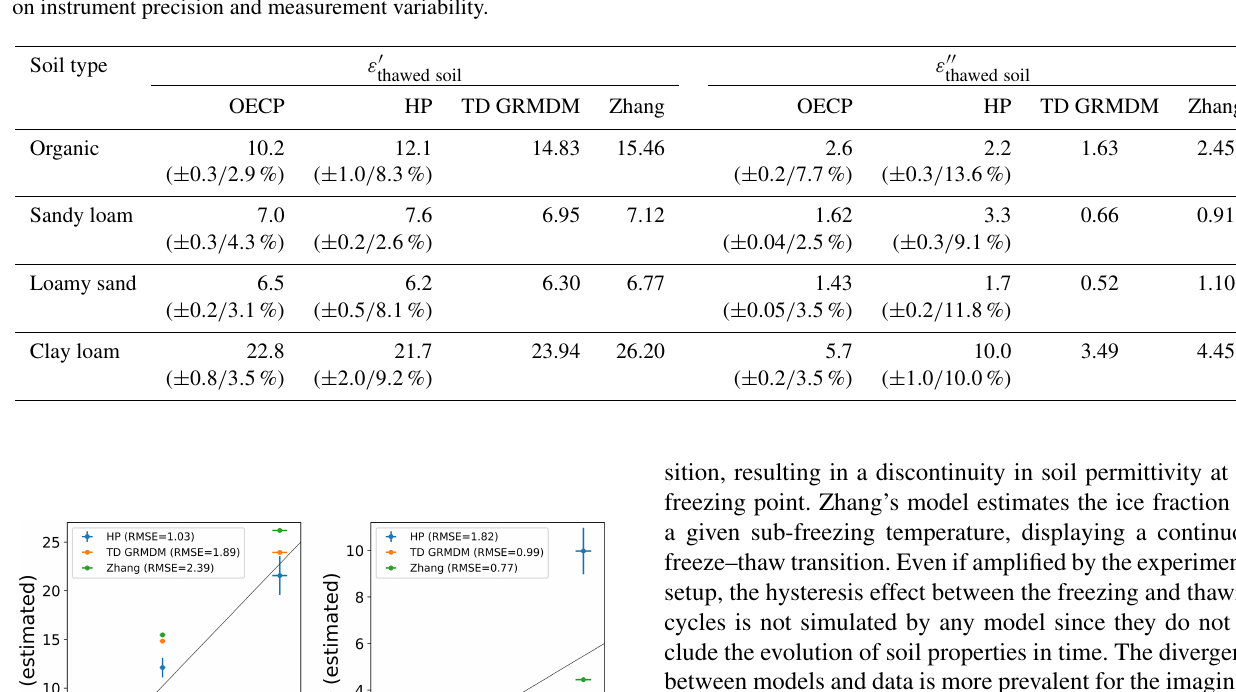
Figure 8. Same as Fig. 5 but for the clay loam soil sample (see Table 1). Experiment conducted from 6 to 15 April 2018. Table 2. Modeled and measured complex permittivity of thawed soils. The permittivity in the 5 to 6 ◦ C temperature range (stable plateau) is averaged over the multiple freeze–thaw cycles depicted in Figs. 5 through 8. Absolute and relative uncertainties (in parentheses) are based on instrument precision and measurement variability.